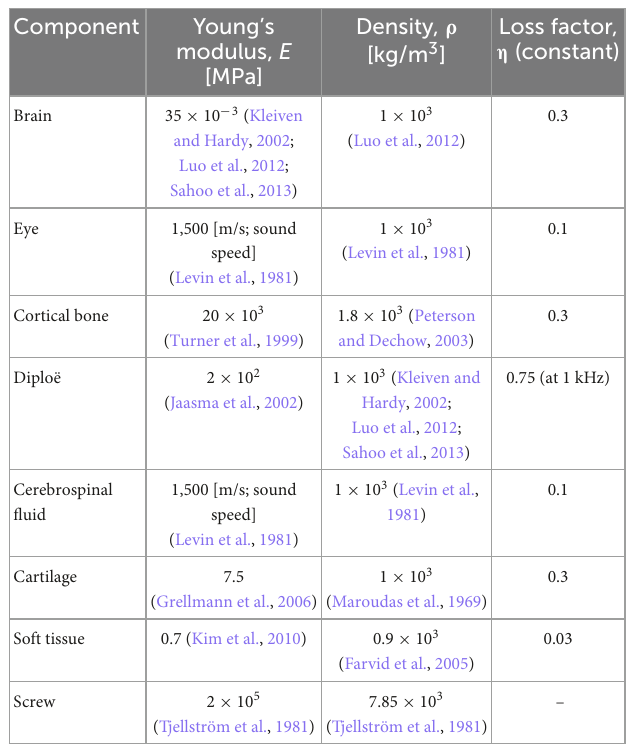
TABLE 2 Properties of 3D finite-element head